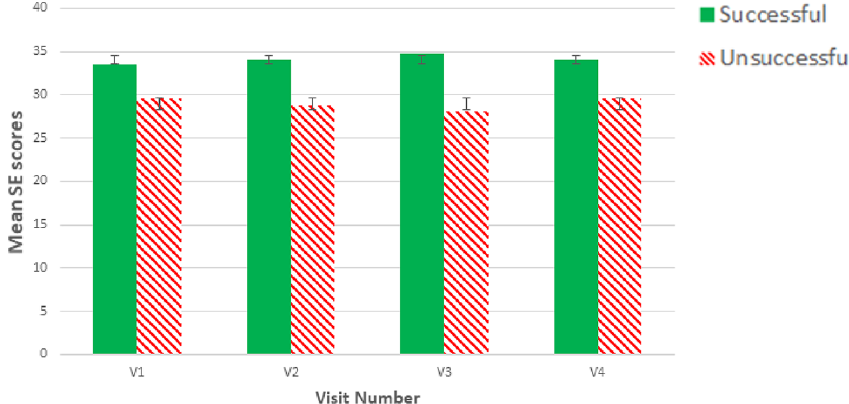
Figure 5. Bar graph depicting correlation between SE and neurofeedback success for all